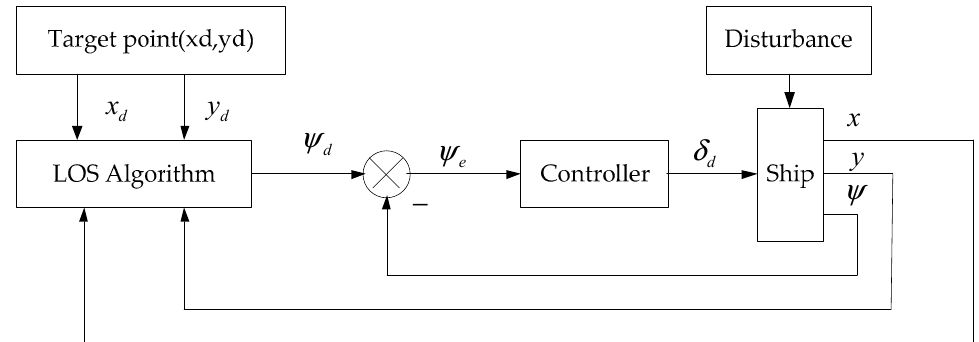
Figure 2. Principle diagram of automatic berthing control for an unmanned ship.